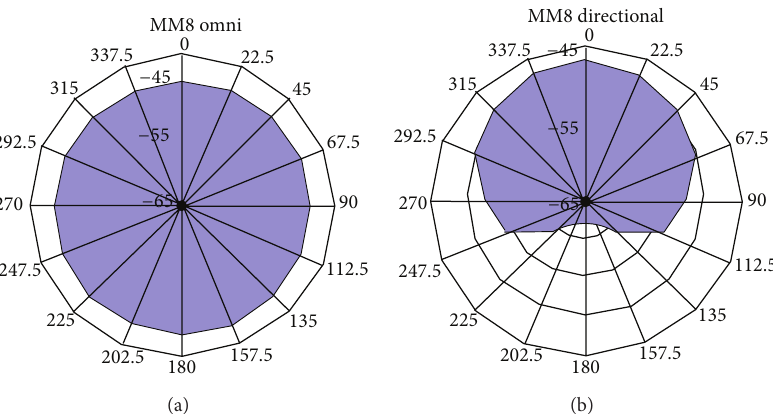
Figure 2: The sensitivity of the Phonac MM8 microphone in two different settings, omnidirectional and directional (adapted with permission from Phonac).